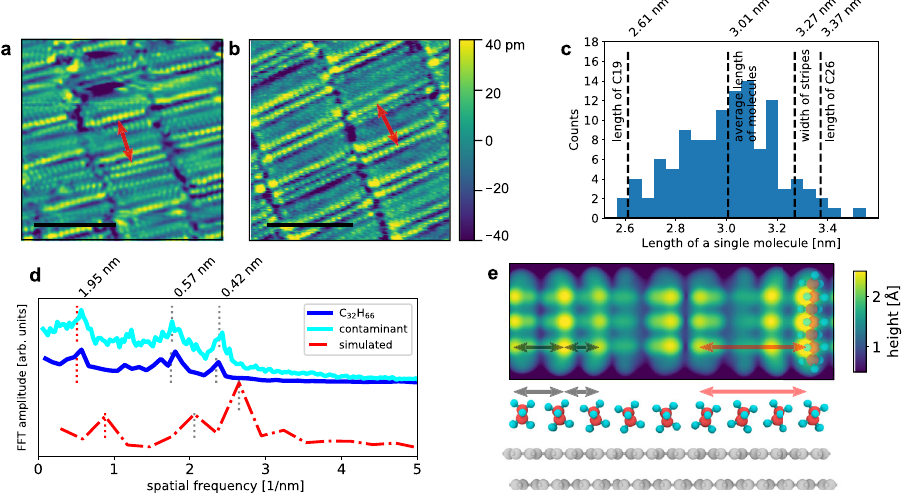
Fig. 3 | Molecular structure from STM and ab initio density functional theory (DFT) calculations. STM images ofthe a contaminant and b C 32 H 66 monolayeron HOPG at 9K (tip stabilization: 500mV, 30pA, scale bars: 4nm). Red arrows show the quasiperiodic superlattice spacing. c Distribution of the individual molecule lengthsinthecontaminantmonolayer. d 1DFouriertransformsalongthestripesof contaminant (cyan) and C 32 H 66 (blue) topographic images showing the periodi- cities of the molecular spacing and quasiperiodic 1D superlattice. The red curve is the Fourier transform of the simulated STM image e ), perpendicular to the mole- culeaxis.Dashedlinesmarktherealspaceperiodicitiesofthepeaksasdetermined